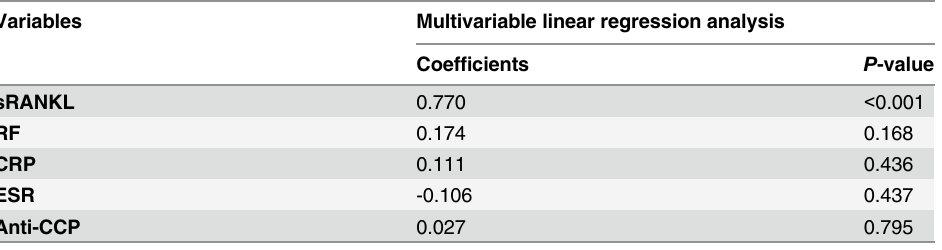
Multivariable linear regression analysis was used to assess the independent contribution of the variables. sRANKL concentrations had the strongest correlation with sIgD concentrations in